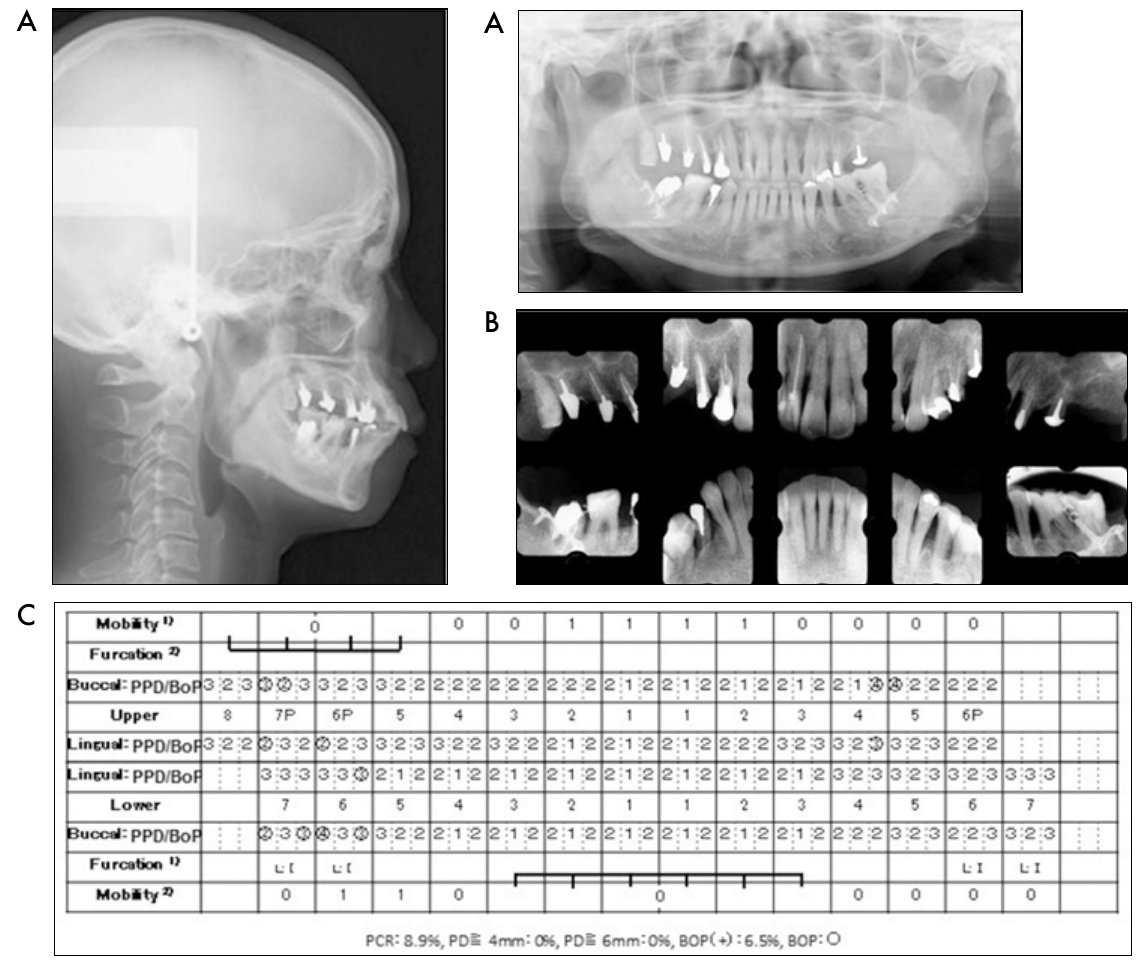
Figure 7. Clinical conditions at the end of the active orthodontic treatments. A: Pantomographic and cephalometric X-ray photographs. B: Periapical radiographs. C: Periodontal chart. 1) According to the classification by Miller (1964), 2) According to the classification by Hamp et al. (1975). PPD: Probing Pocket Depth, BoP: Bleeding on Probing.